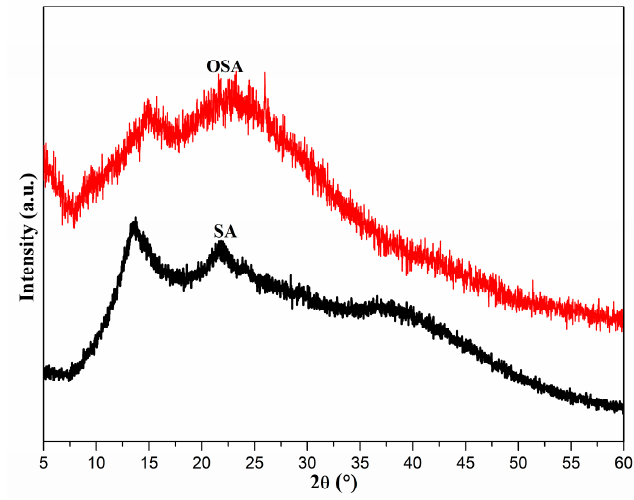
Figure 6. XRD patterns of SA and OSA. Thermogravimetric analysis was the most effective method to characterize the different thermal stability of SA and OSA, which could indirectly reflect the change of molecular structures of alginate during the oxidation reaction. During the test, since the mass of the samples will change with the increase in temperature, the thermal stability of SA and OSA can be judged by comparing the initiating decomposition temperature and the final weight loss rate [47]. As shown in Figure 7a, the weight loss of the samples at the temperature below 100 ◦ C corresponds to the evaporation of water in the samples. Major weight loss occurred at the temperature ranging from 200 ◦ C to 300 ◦ C, which resulted from dehydration of hydroxyl group along the alginate backbone and its thermal decomposition of hexuronic segments [48,49]. The total weight loss rates of SA and OSA at 800 ◦ C were 74% and 77%, respectively. Compared with SA, OSA possessed lower residual weight, which may be ascribed to the oxidation of hydroxyl groups of SA. From the DTG curves of SA and OSA in Figure 7b, it can be observed that both SA and OSA displayed two main weight loss stages. The maximum rate of the first weight loss stage occurred at 100~150 ◦ C, which was ascribed to the removal of physically adsorbed water and bound water from the polymer materials [27,28], while the second weight loss stage occurred at 200~300 ◦ C and was attributed to the thermal decomposition of the polymer materials, which was gradually thermally cracked into CO, CO 2 , and H 2 O, resulting in a rapid decline in their weight [33]. The temperatures corresponding to the maximum rates of the thermal decomposition weight loss of SA and OSA were 249.6 and 232.2 ◦ C, respectively. Obviously, the initiating thermal decomposition temperature of OSA was lower than that of raw SA, indicating that the thermal stability of OSA decreased after the oxidation reaction. This result was ascribed to the destruction of the intramolecular hydrogen bond for the cleavage of the C2–C3 bond of alginate uronic acid monomer during the oxidation process, thereby improving the molecular flexibility of